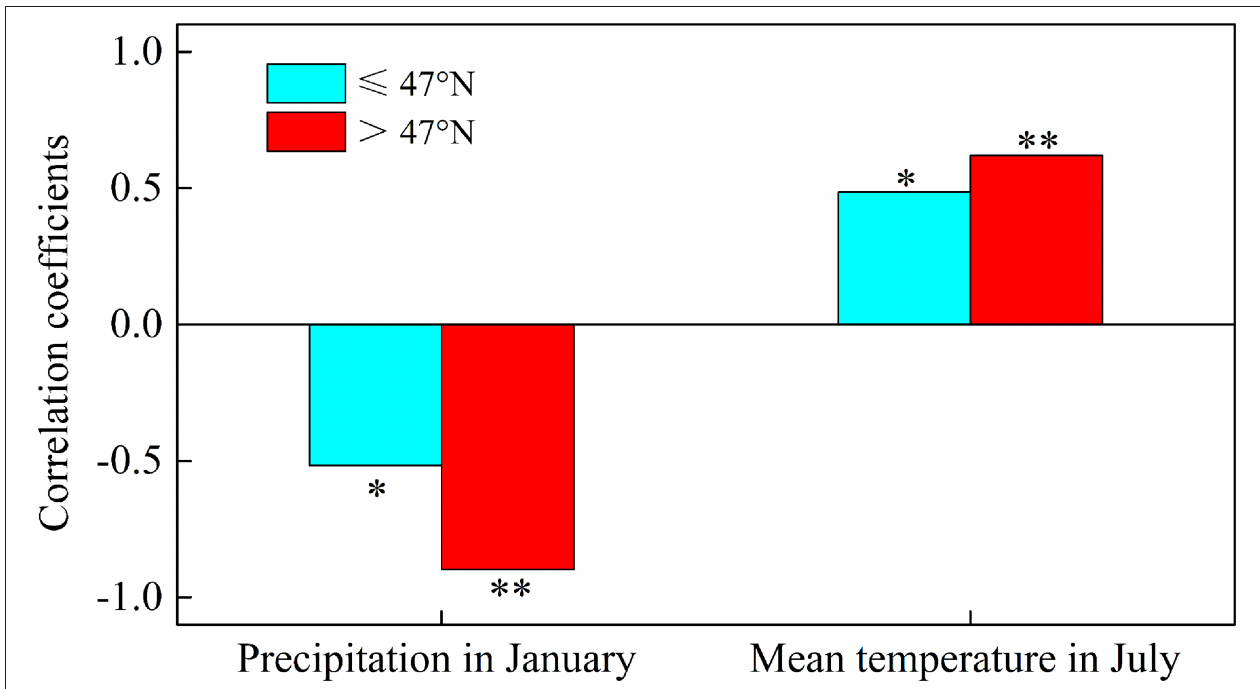
FIGURE 8 | Correlation coefficients between marsh AGB and precipitation in January and mean temperature in July in two different regions of the Sanjiang Plain, south of 47 ◦ N ( ≤ 47 ◦ N) and north of 47 ◦ N ( > 47 ◦ N). ** and * mean significantly at the levels of p < 0.01 and p < 0.05, respectively.